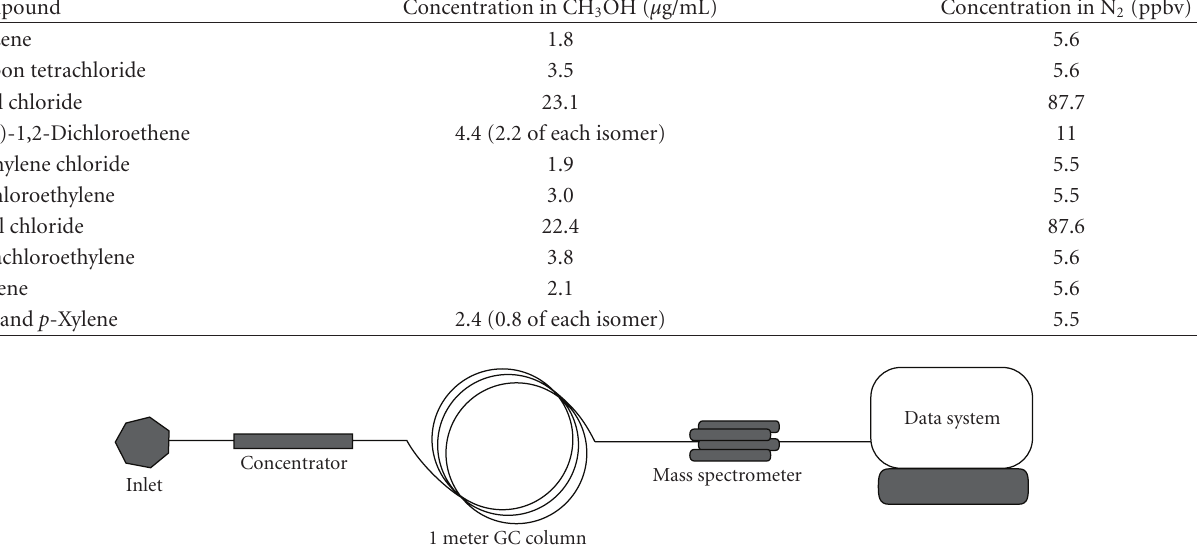
Table 2: Composition of standard mix 2 used for method detection limits determination.